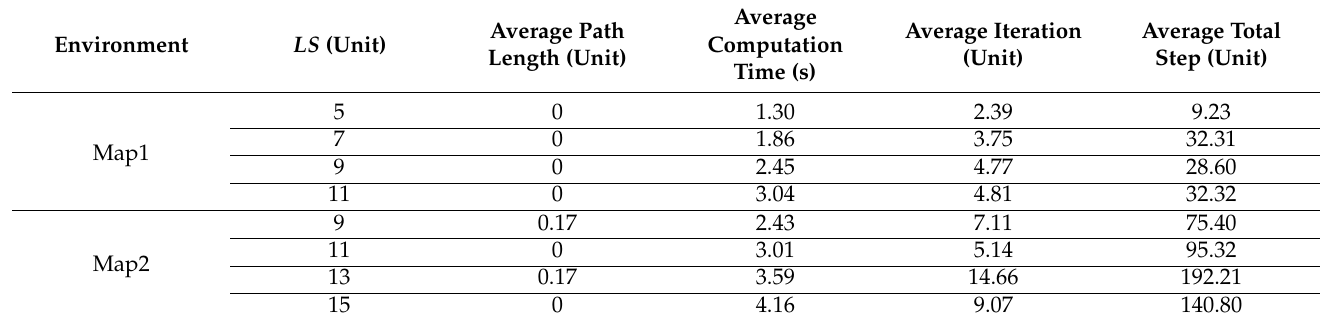
Table 8. Local Environment Average Performance Standard Deviation